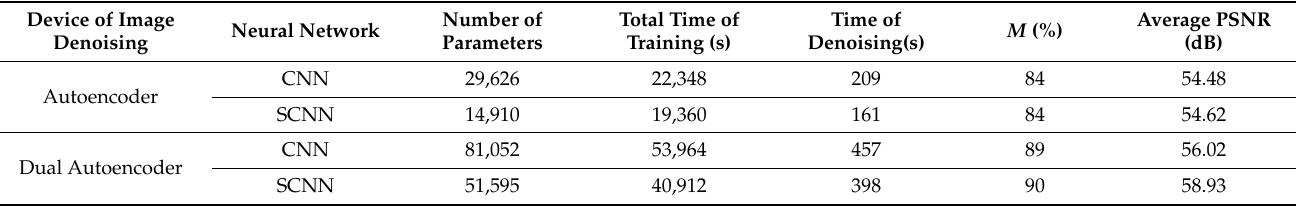
Table 3. Speckle noise reduction.